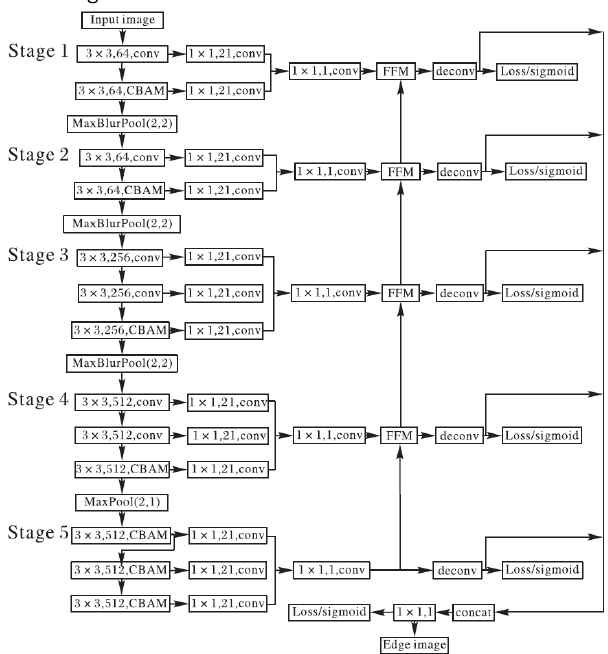
Figure 1. Proposed model structure.